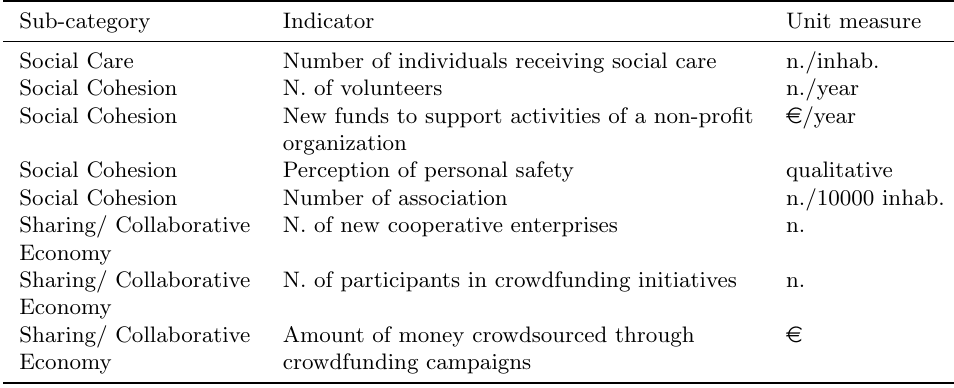
Table 5: Community and social cohesion